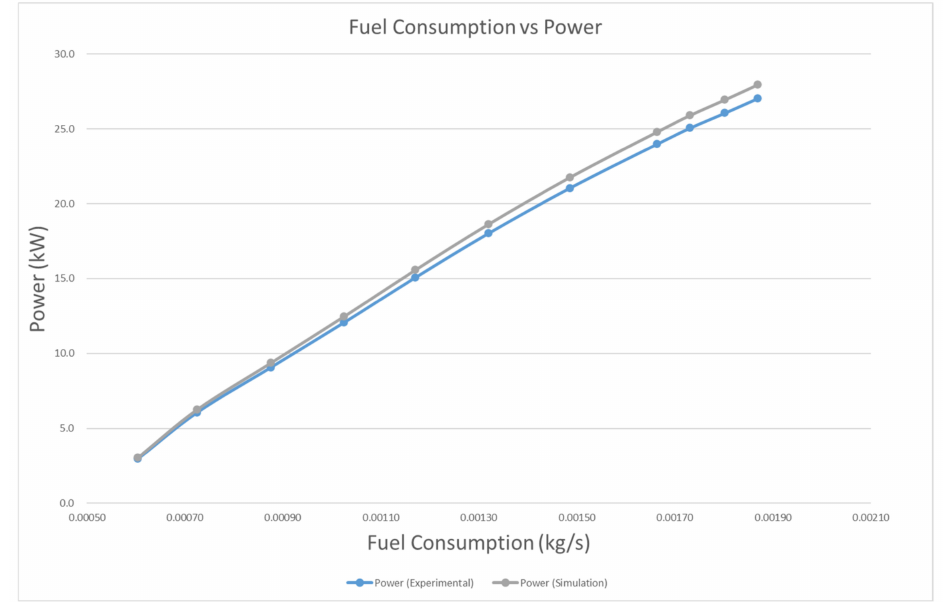
Figure 2. Power vs. fuel